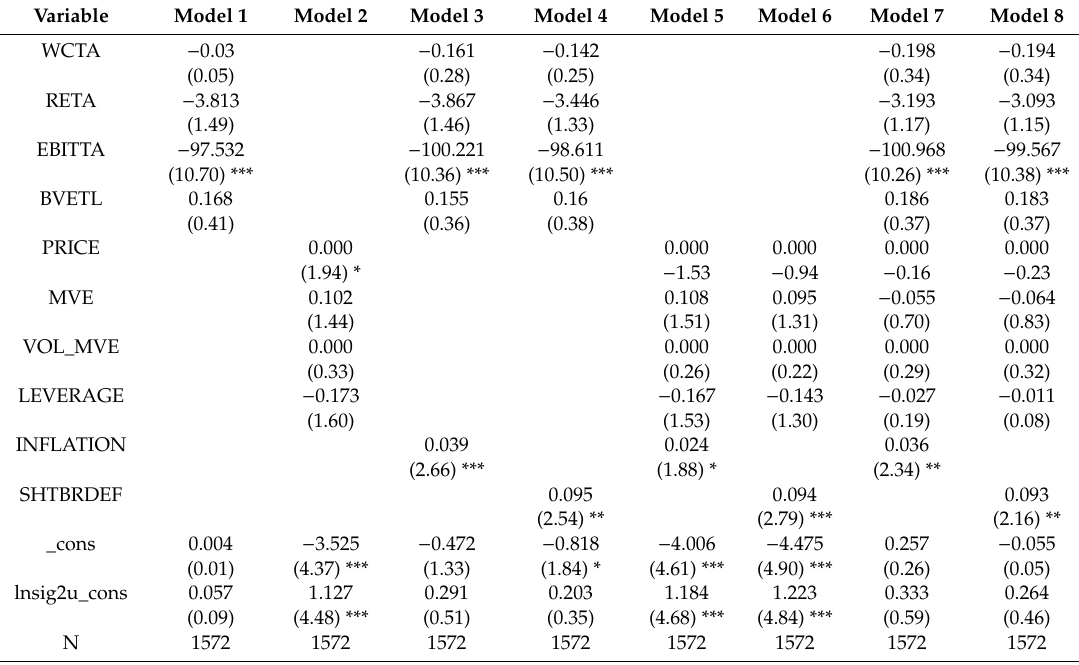
Table 5. Financial distress of Vietnamese listed firms during GFC